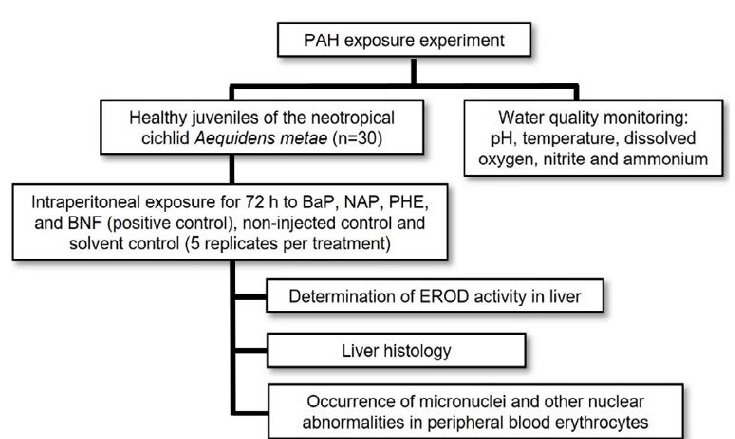
Fig. 1: Summary of the methodology used at the experiment with Aequidens metae exposed to PAH during 72 h